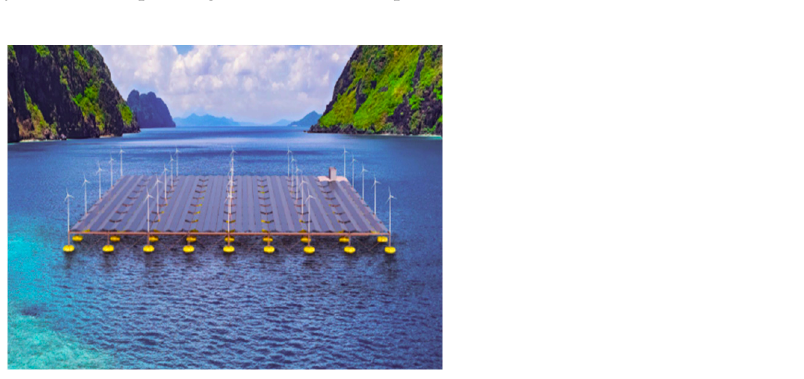
Figure 9. Multi-purpose platform combining offshore floating photovoltaic, wind turbine, and aquaculture [39]. Reprinted with permission from Ref. [An offshore floating wind–solar–aquaculture system: Concept design and extreme response in survival conditions]. 2020, Zheng, X.